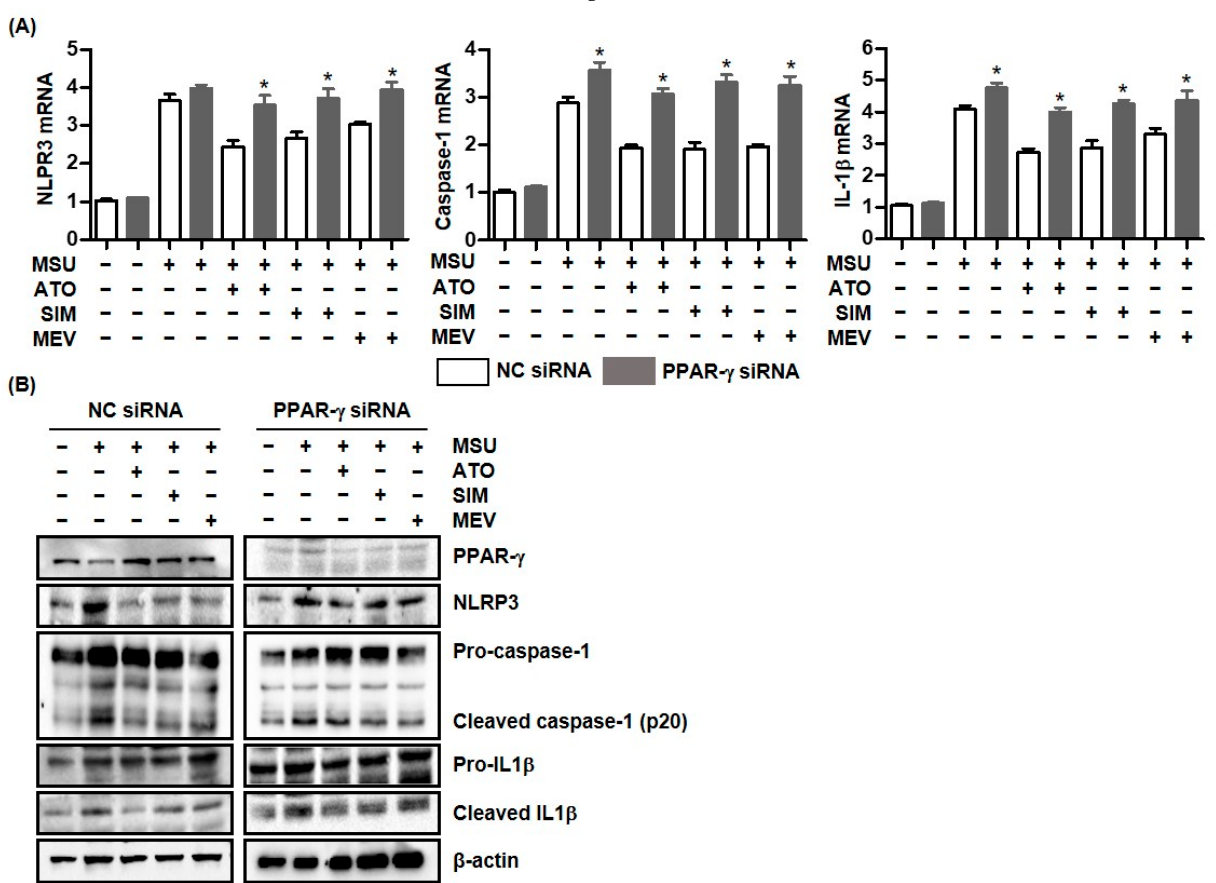
Figure 3. The inhibitory effect of statins on the MSU-induced inflammatory response is attenuated in PPAR- γ deficient cells. ( A ) NLRP3, caspase-1, and IL-1 β mRNA expression by addition of statins in THP-1 cells transfected with and without PPAR- γ siRNA under stimulation with MSU crystals (0.3 mg/mL). ( B ) PPAR- γ , NLRP3, caspase-1, and IL-1 β protein expression by addition of statins in THP-1 cells transfected with and without PPAR- γ siRNA under stimulation with MSU crystals (0.3 mg/mL). *: p < 0.05, compared to cells transfected with NC siRNA using Kruskal–Wallis test followed by Dunn’s multiple comparison test. Values presented as mean ± SEM of three independent experiments. Images are representative of three independent experiments. Abbreviations: PPAR- γ , peroxisome proliferator-activated receptor- γ ; MSU, monosodium urate; IL-1 β , interleukin-1 β ; ATO, atorvastatin; SIM, simvastatin; and MEV, mevastatin.